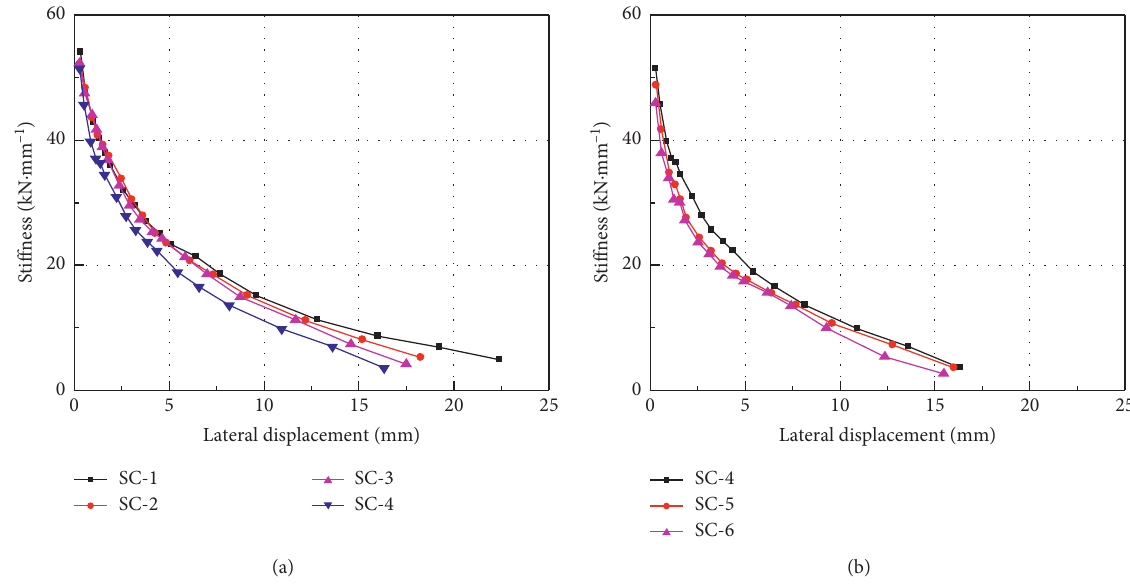
Figure 10: Stiffness degradation curves of the specimens. (a) Corrosion-level-induced changes. (b) Stirrup-ratio-induced changes.